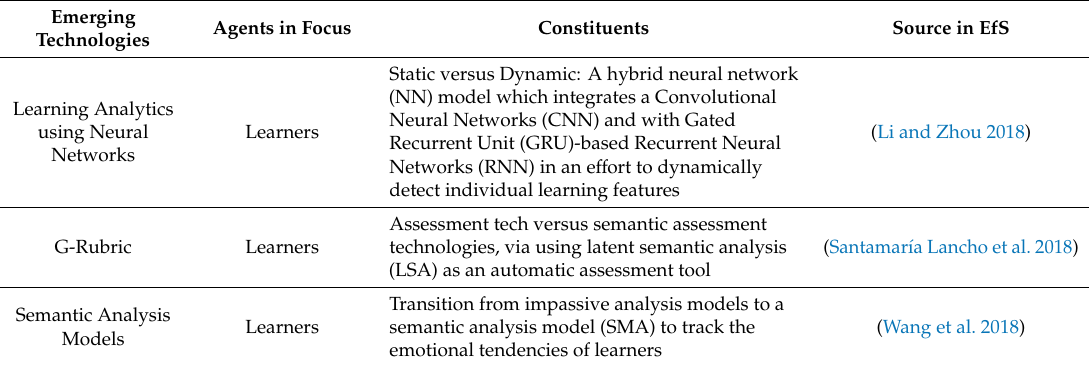
Table 2. Structuration constituents among incumbent technologies and emerging